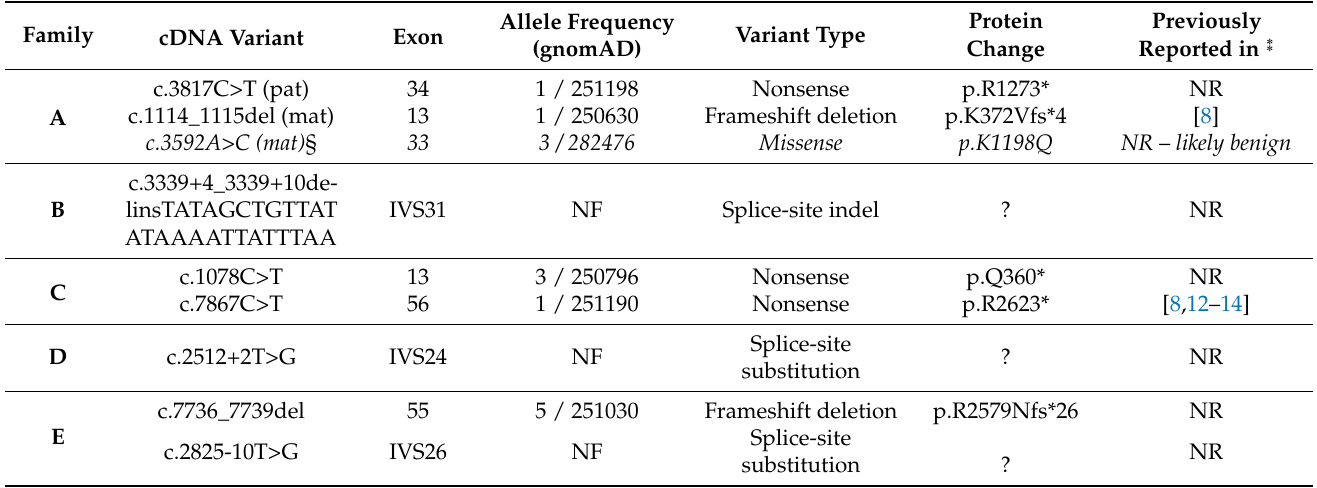
Table 2 lists the VPS13A variants identified in the first five families (A–E) next to their frequency in the Genome Aggregation Database (gnomAD) and the expected protein changes. Table 2. ChAc patients: molecular findings. VPS13A variants on cDNA, their allele frequency in the GnomAD database, variant type and predicted protein change. § Missense variants in VPS13A are usually benign and the p.K1198Q variant is anyhow in cis with the pathogenic frameshift c.1114_1115del variant. NF: Variant not found in gnomAD exomes/genomes; ⁑ only papers with independent patients quoted; NR: apparently not reported.